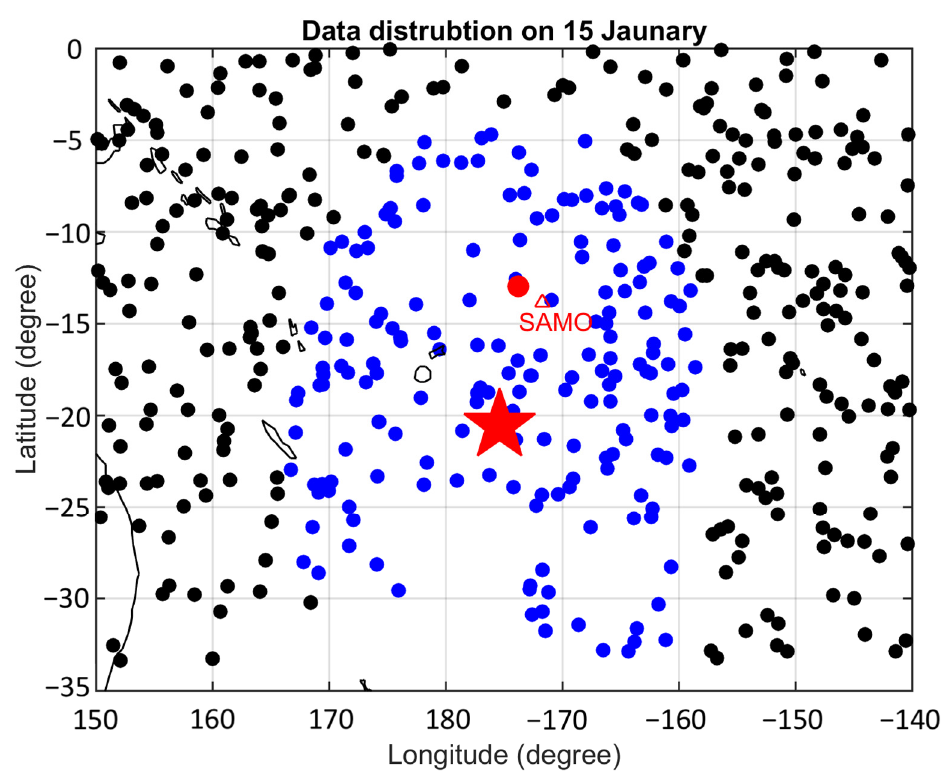
Figure 1. Location of the ionospheric radio occultation (RO) electron density (Ne) soundings (blue dots) within 2000 km away from the Tonga eruptions (red pentagram). Each dot indicates the averaged longitude and latitude of the tangent points of each RO sounding. The triangle is the ground-based GNSS receiver SAMO (13.76°S, 171.74°W). The red dot indicates the location of the ionosphere pierce point (at 350 km altitude) of the total electron content (TEC) between the receiver and the BeiDou Navigation Satellite System geostationary satellite C01.